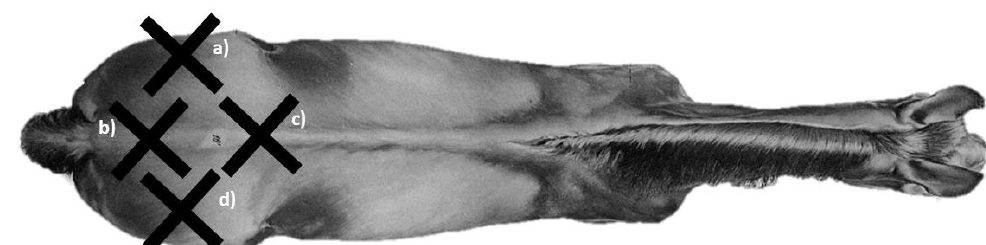
Figure 4. ( a ) Left hind quarter impact location. ( b ) Sacral vertebrae impact location. ( c ) Lumbosacral vertebrae impact location. ( d ) Right hind quarter impact location.